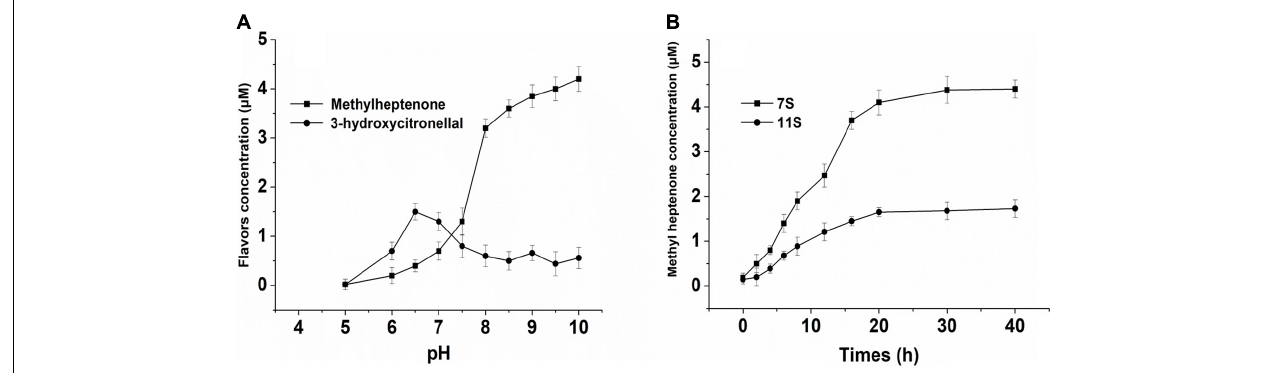
FIGURE 5 | (A) Effect of different pH solution of NSPI—catalyzed to citral. (B) Effect of 7S, 11S-catalyzed to citral. The concentration of protein is 1% (w/v), 20 mmol/L potassium phosphate buffer/NaOH, and primary citral’s concentration is 24 µ mol/L.